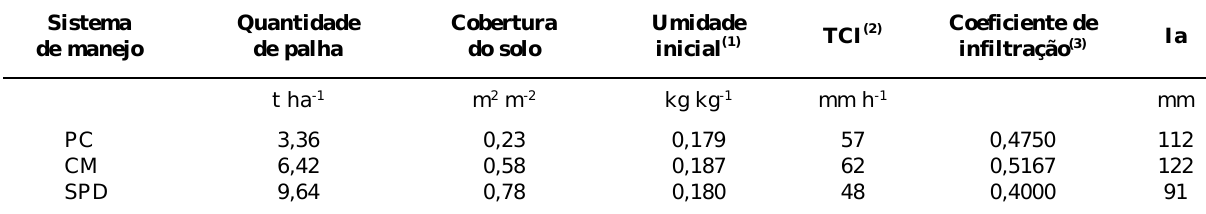
Quadro 3. Quantidade de palha, percentual de cobertura do solo, taxa constante de infiltração (TCI), coeficiente de infiltração, infiltração acumulada (Ia), nos sistemas de manejo em preparo convencional (PC), cultivo mínimo (CM) e sistema plantio direto (SPD), na 3 a época